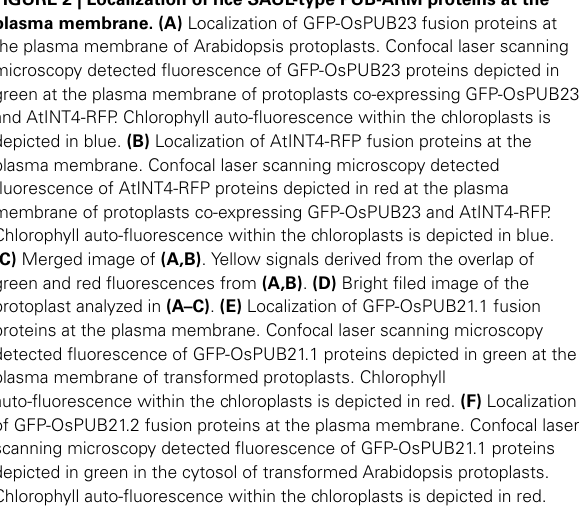
and P. patens , 50 and 31 PUB-ARM proteins were